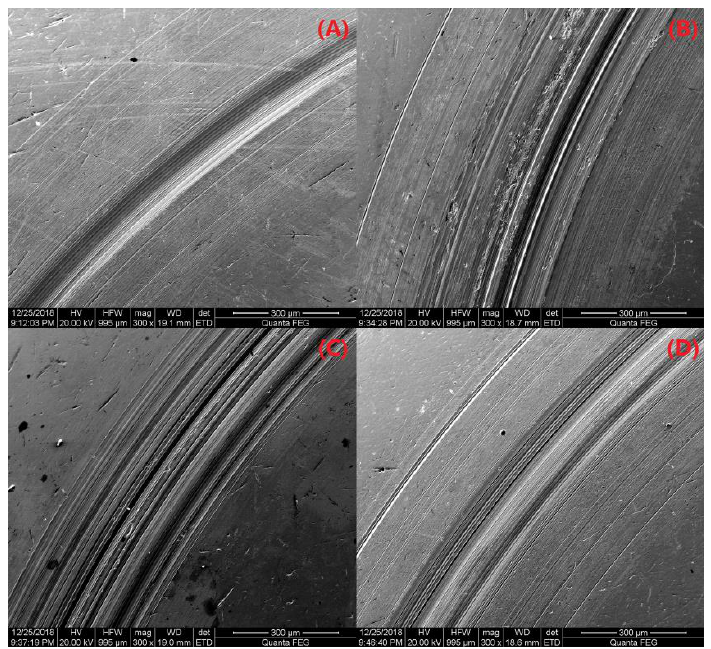
Figure 12. SEM images of the upper ball of ( A ) PAO, ( B ) PAO-PS/P-MMT, ( C ) PAO-PS/P-SLS-MMT, and ( D ) PAO-PS/P-KH570-MMT.